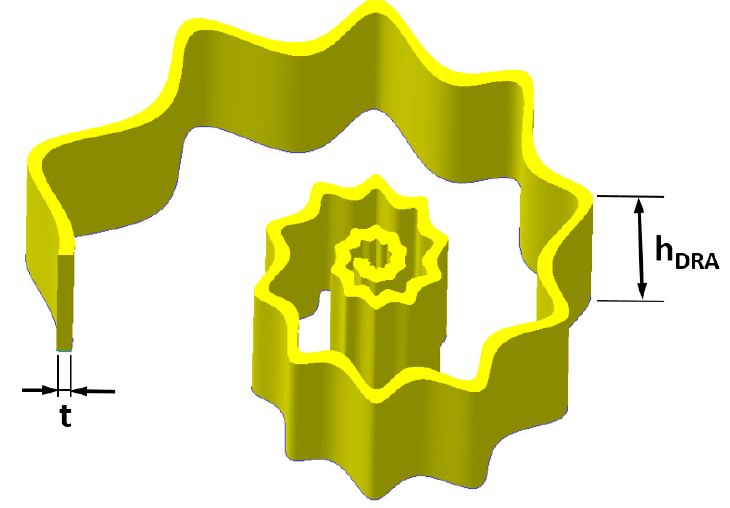
Figure 1. A 3D model of the Spiral shell Dielectric Resonator Antenna (SsDRA).